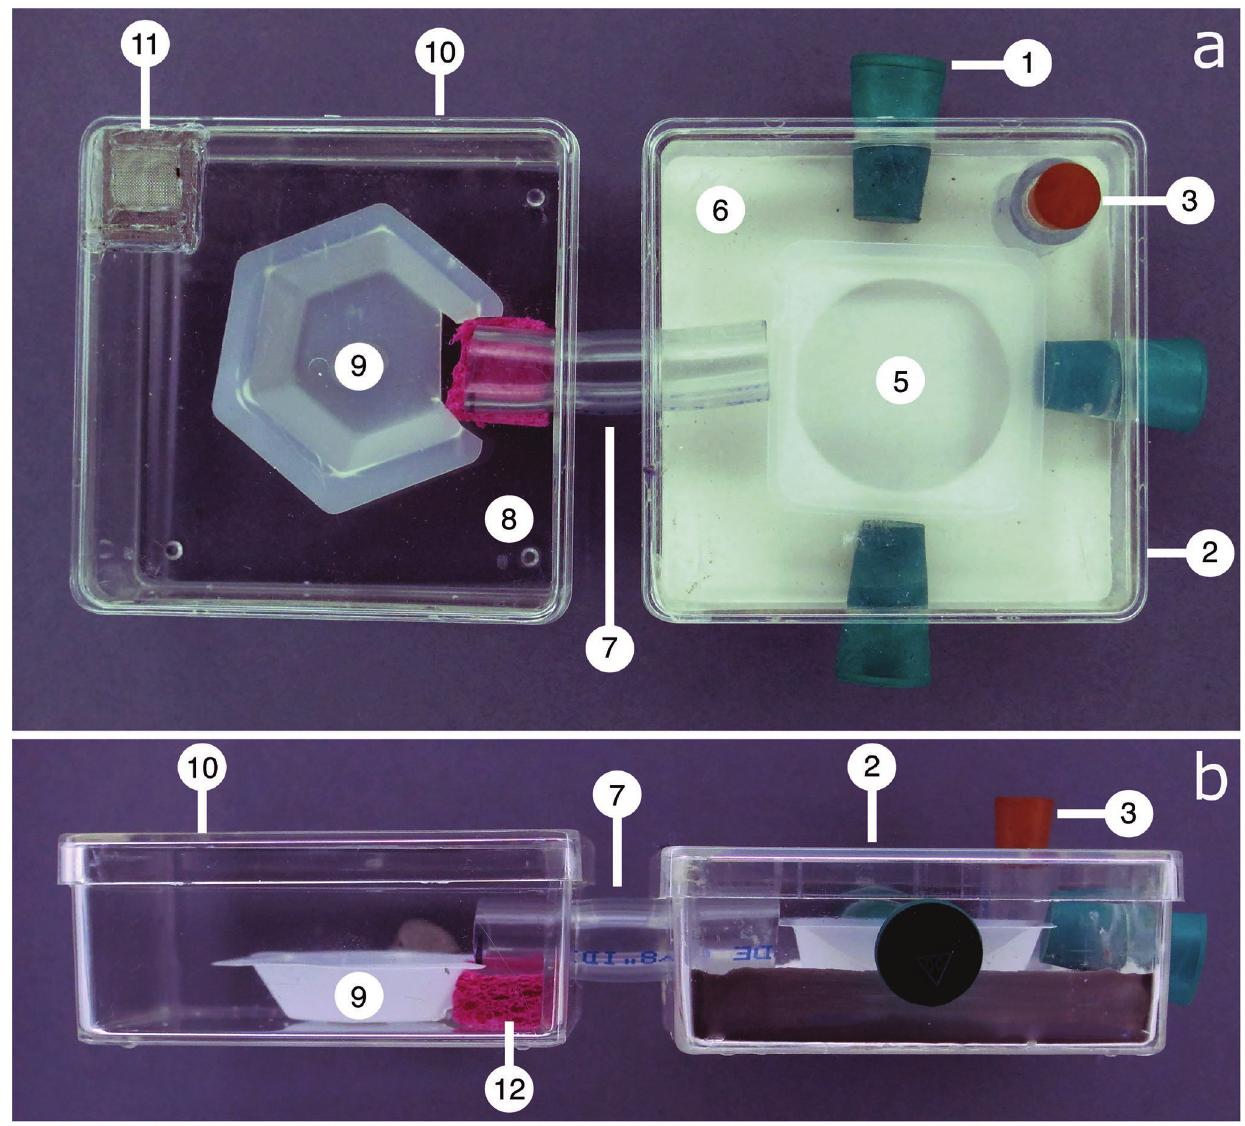
Fig 7. Nest box laboratory set up. a. Garden nest box (right) and auxiliary box (left) as seen from above. b. Garden nest box (right) and auxiliary box (left) as seen from the side. 1. Neoprene stopper No. 00; 2. Square polystyrene garden nest box; 3. Small stopper No. 0000; 5. Weigh boat used as a platform to separate the fungus garden from the plaster. 6. Dental stone (plaster) poured into the bottom of the box to a depth of ~0.5 cm. 7. Tygon tubing connecting fungus nest box to the auxiliary (foraging) box. 8. Bottom of auxiliary box without dental stone (plaster). 9. Weigh boat used to serve the food for the ants. Food in the lab consists mostly of Cream of Rice, caterpillar frass, oak catkins, finely diced inner white part of orange peel, and small pieces of apple. 10. Auxiliary (feeding/foraging) box. 11. Ventilation hole (~1 cm) in lid of auxiliary box, covered with fine-mesh, stainless-steel, wire screen fused by melting to the lid. 12. Small piece of sponge serving as step for ants entering and exiting via the connecting